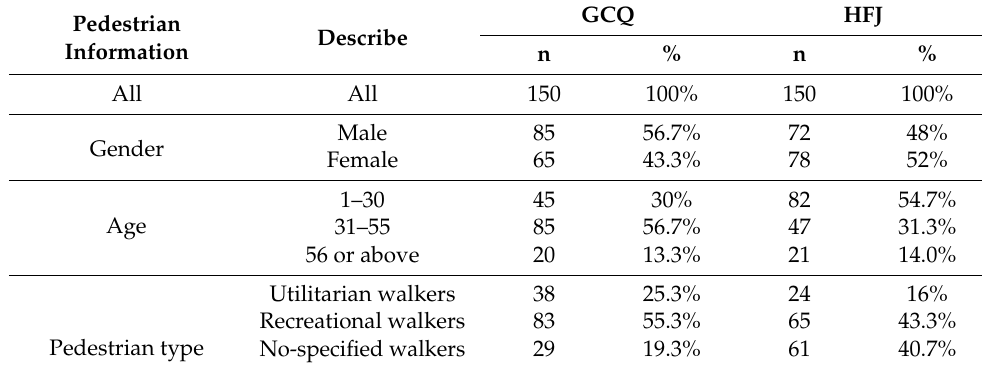
Table 2. Pedestrian information in Hefang Street business block and Gongchen Bridge life block.